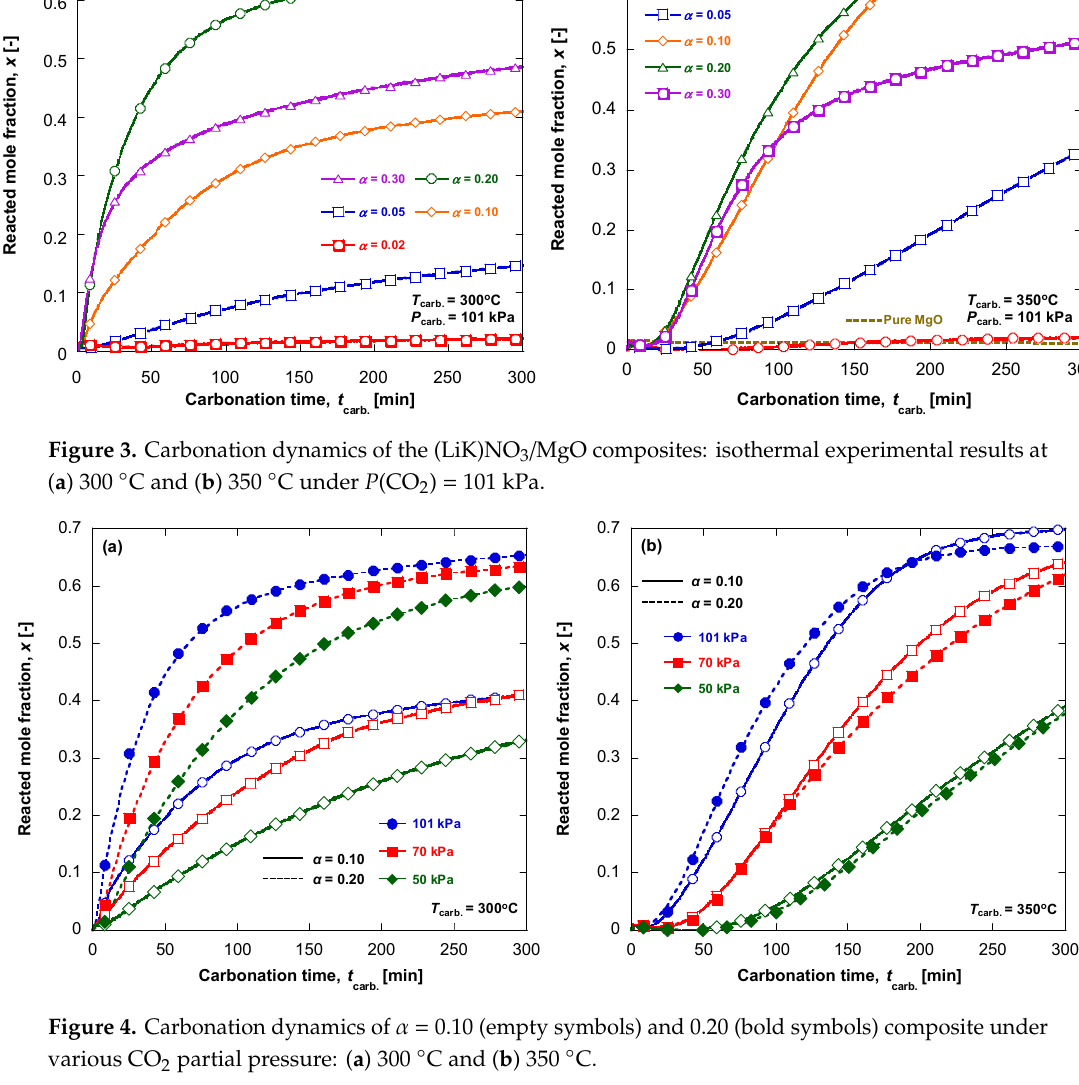
Figure 4. Carbonation dynamics of α = 0.10 (empty symbols) and 0.20 (bold symbols) composite under various CO 2 partial pressure: ( a ) 300 ° C and ( b ) 350 ° C.